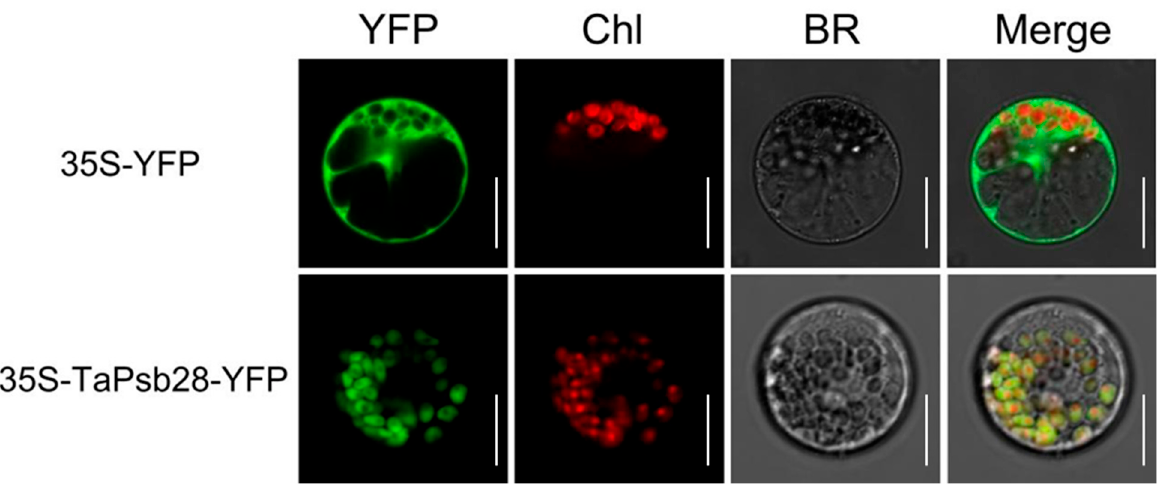
Figure 3. Subcellular localization of TaPsb28 -YFP in maize mesophyll protoplasts. YFP: yellow fluorescent protein; Chl: chloroplast self-luminescence; BR: bright field. Bars = 10 µ m.